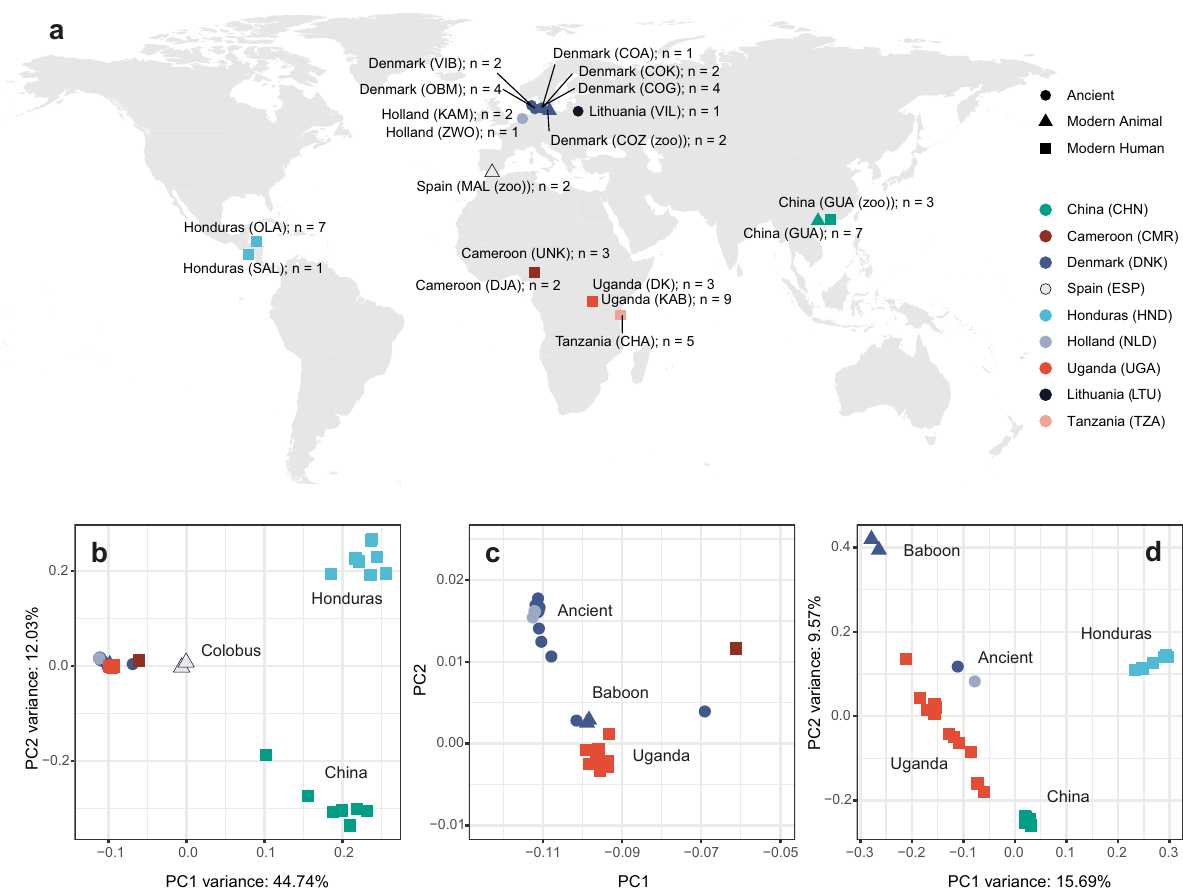
Fig. 1 Global sampling distribution and broad-scale genetic relatedness of ancient and modern Trichuris trichiura . a World map showing the approximate sampling locations of samples used in the study, highlighting geographic regions of ancient and modern sampling and host species. Sample site abbreviations: CHA = Chake; COA = Adelgade, Copenhagen; COG = Gammel Strand, Copenhagen; COK = Kultorvet, Copenhagen; COZ = Copenhagen Zoo; DJA = Dja Fauna Reserve; GUA = Guangdong; KAB = Kabale, Nyakitokoli; KAM = Kampen; MAL = Málaga Zoo; OMB = Odense By Midte; OLA = Olanchito; SAL = San Lorenzo; VIB = Viborg; VIL = Vilnius; ZWO = Zwolle. b Principal component analysis of mitochondrial diversity (56 samples, 802 variants). c Zoomed-in view of the cluster of samples indicated by the dashed box in b , containing ancient, Ugandan, and baboon-derived samples. d Principal component analysis of nuclear diversity using a subset of higher quality samples (31 samples, 2,544,110 autosomal